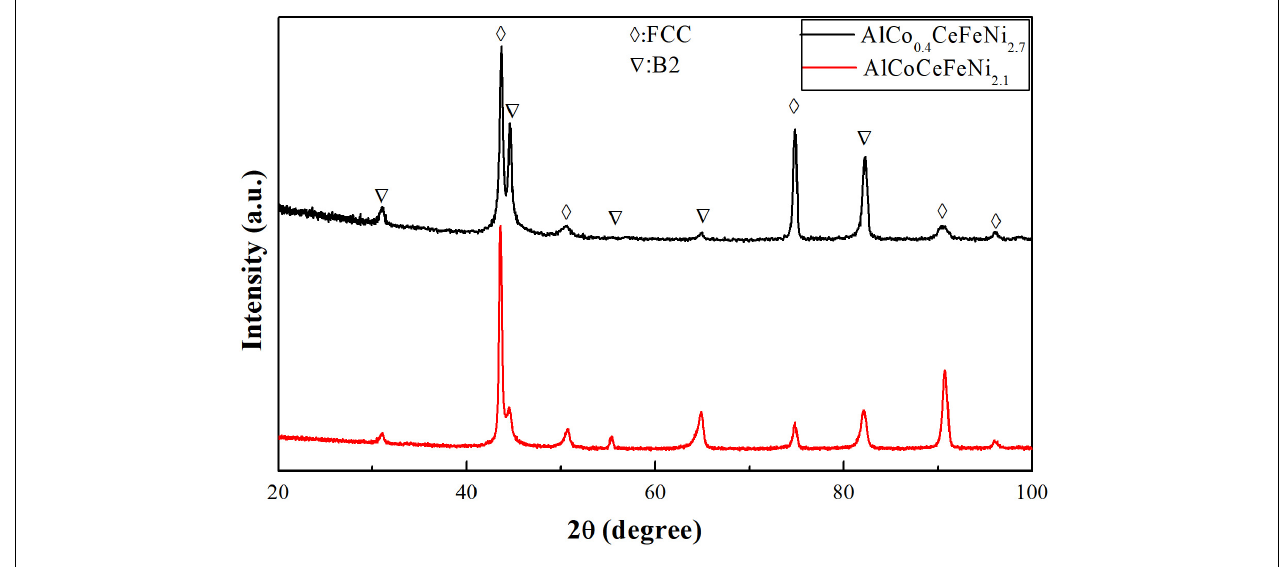
FIGURE 3 | X-ray diffraction (XRD) patterns of the AlCo x CrFeNi 3 . 1 − x alloys.